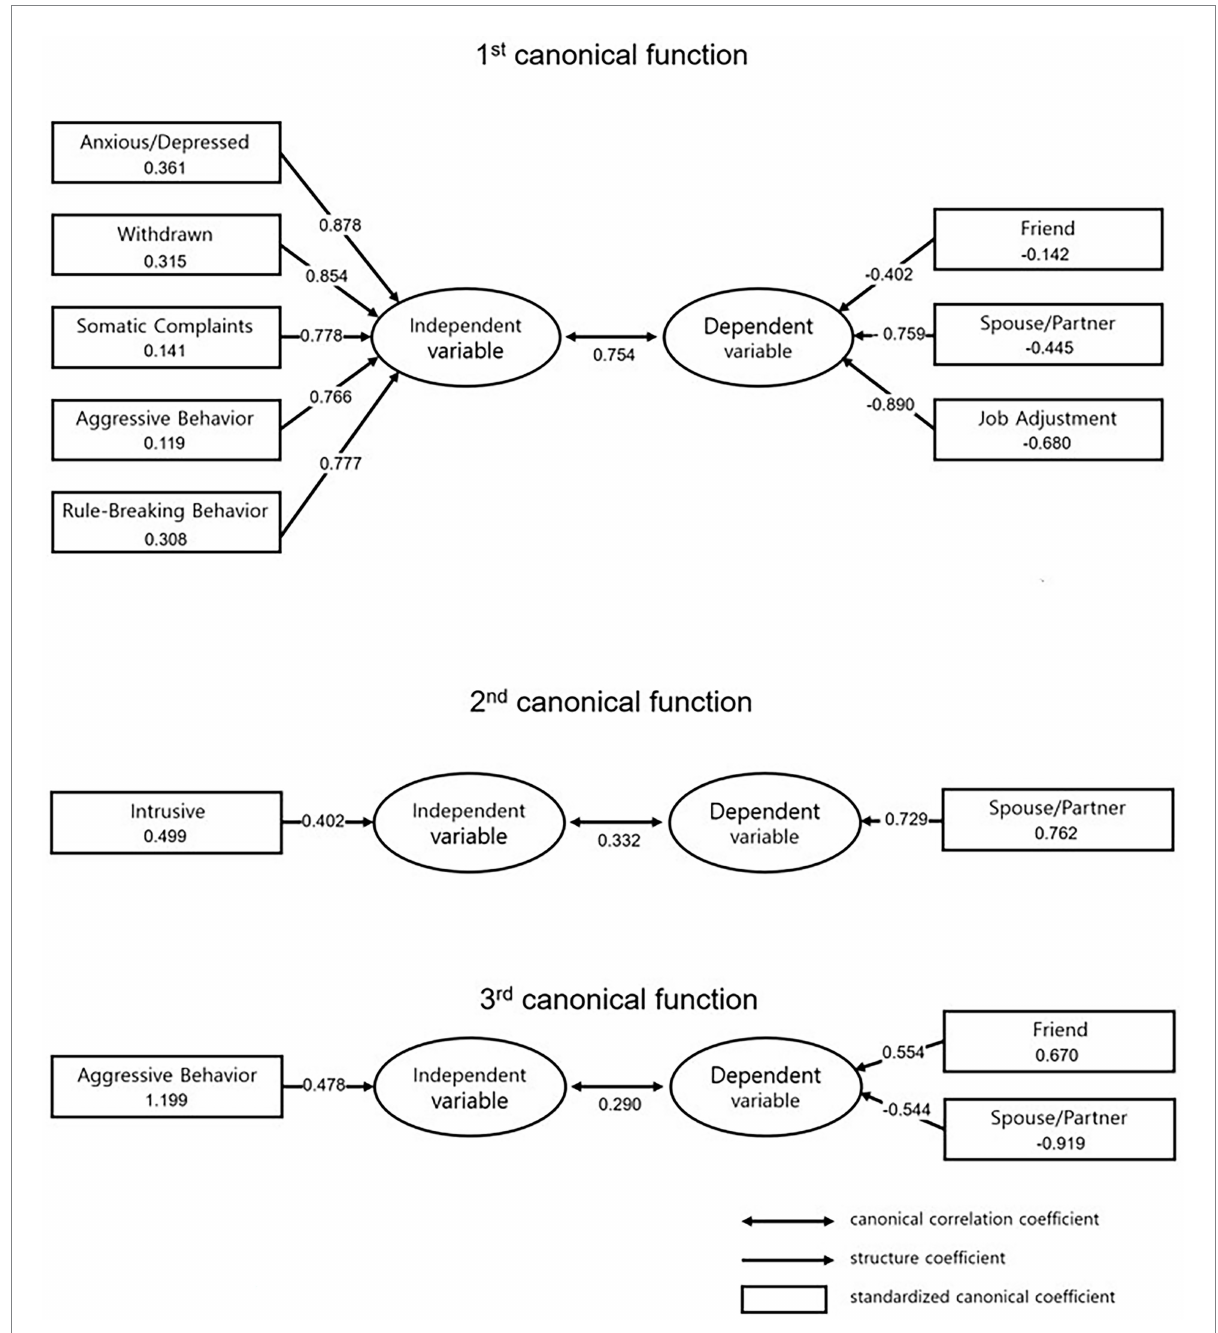
FIGURE 1 Illustration of the first, second, and third function in a Canonical Correlation Analysis